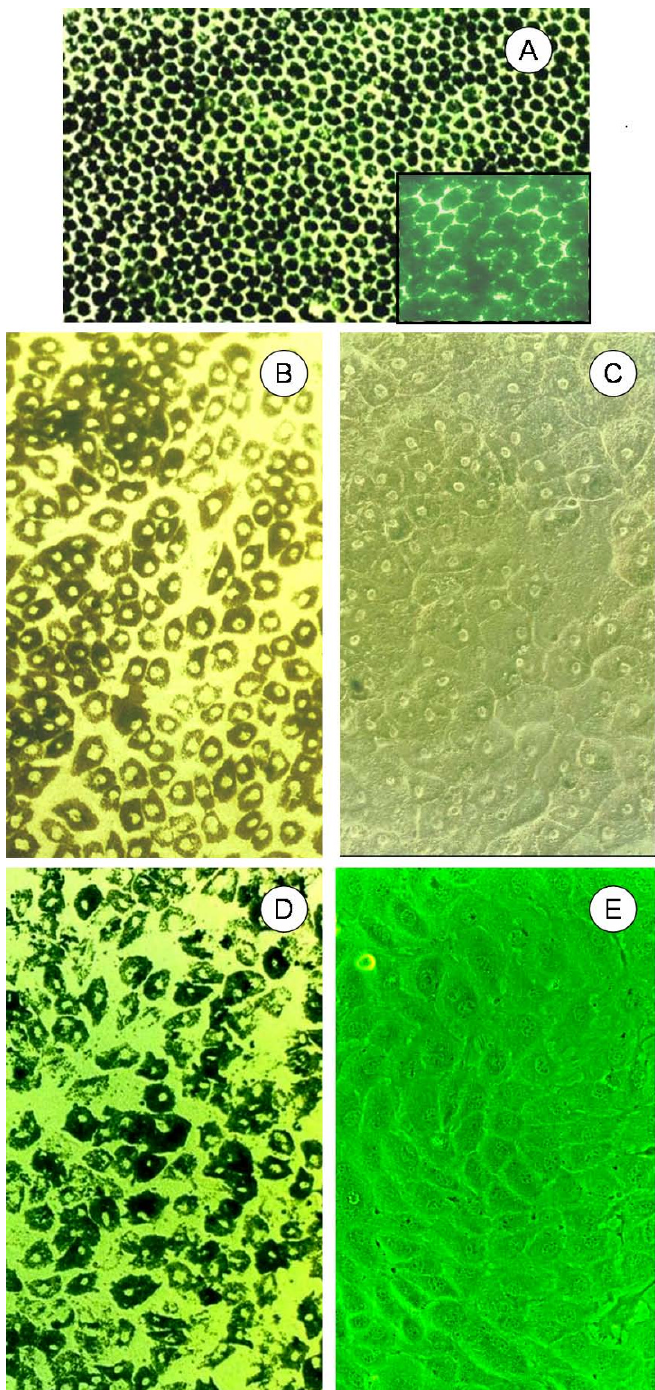
Figure 1 Morphological comparison between in vivo RPE, freshly excised RPE and tRPE cells . A) Melanotic RPE in vivo mor- phology. B) Photograph of a confluent passage 1 primary melanotic RPE culture with the inset as a close-up. C) Photograph of passage 5 primary RPE cells displaying a polygonial morphology. D) Photograph of passage 102 tRPE cells which were